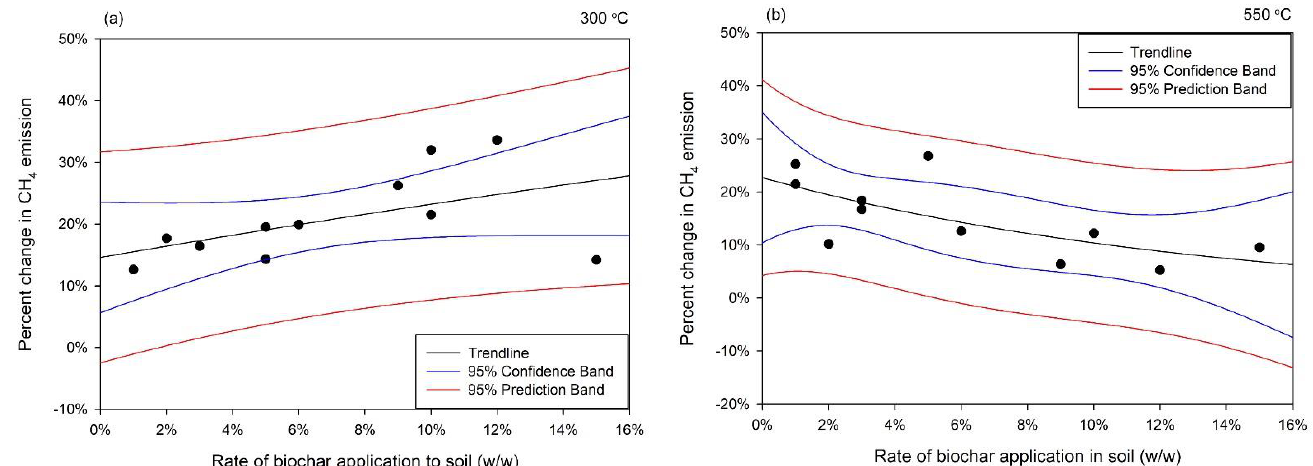
Figure 2. Percentage change in CH 4 emissions as affected by biochar applications at different application rates ( w / w ): ( a ) applied biochar was produced at approximately 300 °C and ( b ) applied biochar was produced at approximately 550 °C. Note: Different units for biochar application rates were all converted into weight percentage, calculated using the mass of applied biochar divided by the mass of impacted soil; the 0% (x-axis) refers to the control soil with no biochar added.